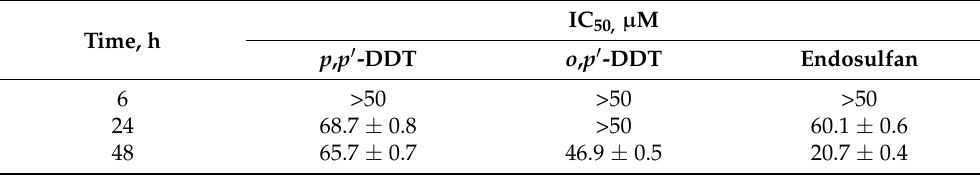
Table 5. The proliferation (IC 50 ) of p , p (cid:48) -DDT, o , p (cid:48) -DDT, and endosulfan against MCF-7 cells. IC 50, µ M Time, h p , p (cid:48)